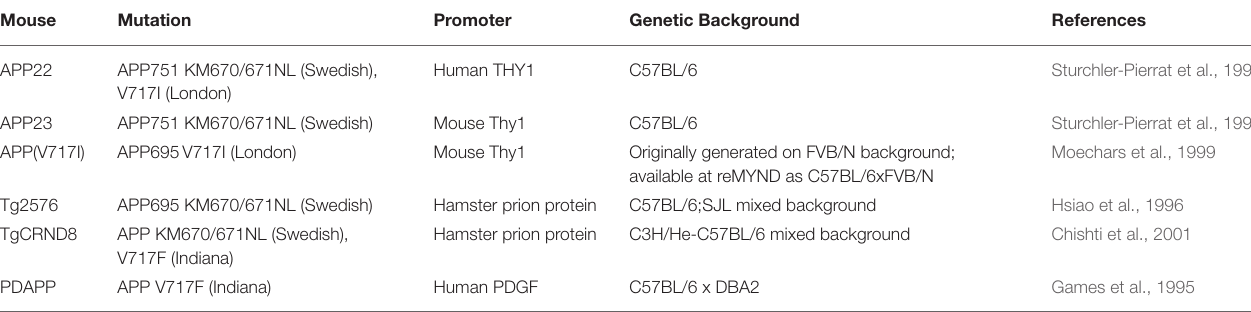
TABLE 4 | Human APP overexpressing transgenic mice referred to in this review (information obtained from Alzforum.org).